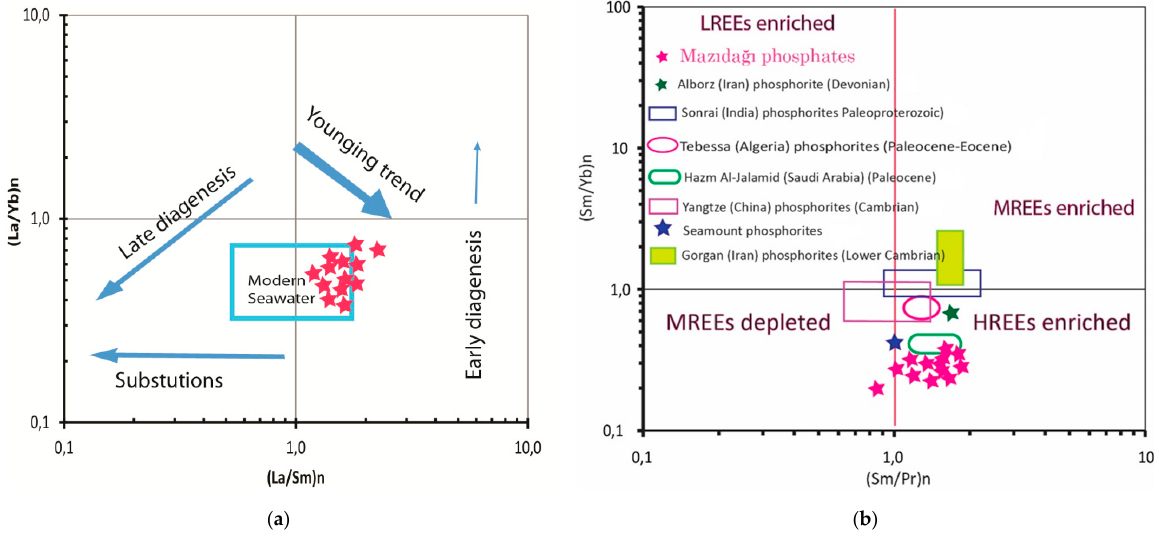
Figure 9. ( a ) The (La/Sm) n vs. (La/Yb) n binary plot showing the influence of diagenesis to phosphate samples [22] and ( b ) the (Sm/Pr)n vs. (Sm/Yb) n diagram displaying the HREE enrichments recorded in the phosphate deposits. Data from [20,22,25,27,64,65,73]. The Eu/Eu* anomalies of the phosphate samples changed from 1.22 to 2.33 (Table 5). In comparison to PAAS, all the phosphate samples had strong positive Eu anomalies. Eu is usually found in a trivalent form, like other REEs. However, Eu +3 can be reduced to Eu +2 in reducing environments [74]. Therefore, according to Bau et al. [75], Eu can be used to investigate sedimentation conditions. Generally, a positive Eu anomaly is interpreted as a proxy for reducing conditions, high temperatures, and a hydrothermal REE supply [20,75]. An Eu anomaly can also be associated with other factors, such as a decrease in temperature or increases in ƒO 2 and pH [76]. While positive Eu anomalies indicate the existence of sub-reduced conditions during the deposition of the sub-layer of phosphates [20], negative Eu anomalies are not indicative of oxic conditions. Under oxic conditions, Eu is strictly trivalent and behaves similarly to other trivalent REEs, leading to Eu/Eu*